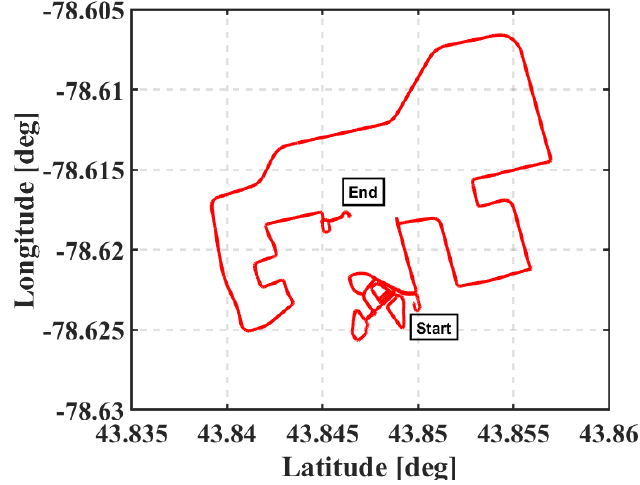
Figure 3. The trajectory of the first vehicular test, Toronto, Ontario, Canada (22 June 2020). Geomatics 2021 , 1 , FOR PEER REVIEW 15